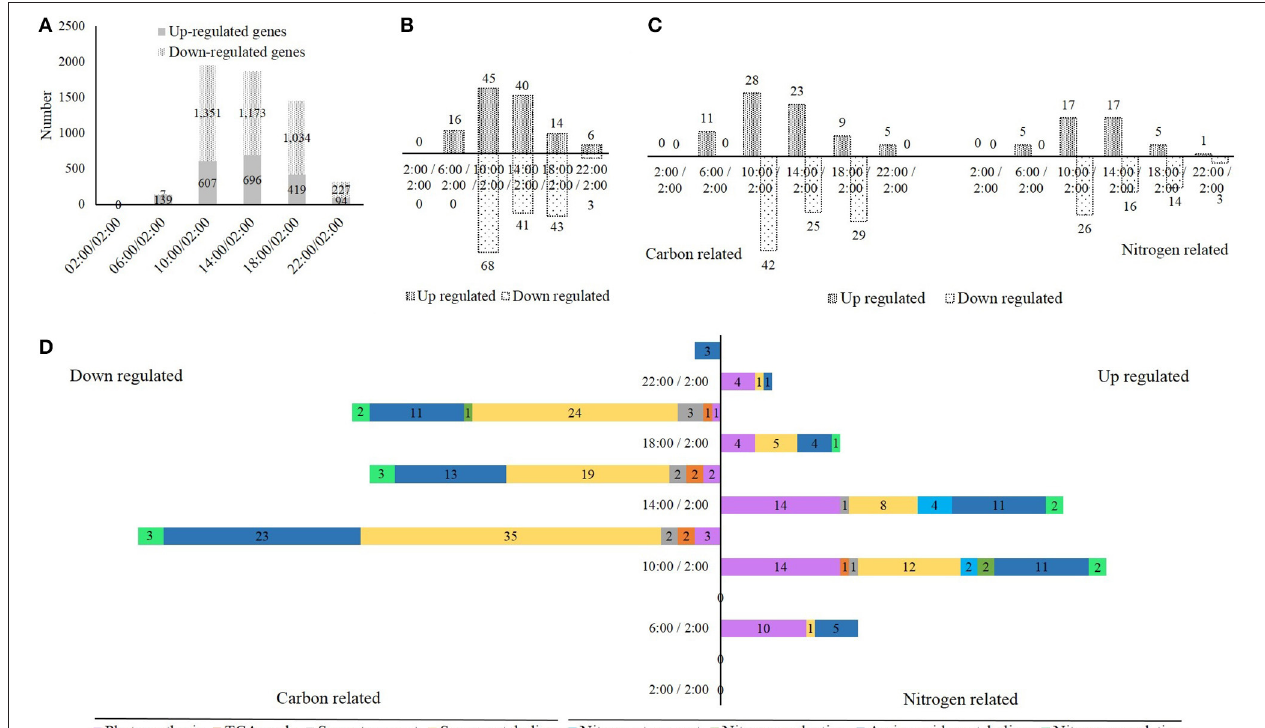
FIGURE 4 | (A) The number of up- and down-regulated genes in the rice shoots at the time of 2:00, 6:00, 10:00, 14:00, 18:00, and 22:00 when compared to the time of 2:00. (B,C) The number of up- and down-regulated carbon and nitrogen metabolism related genes at the time of 2:00, 6:00, 10:00, 14:00, 18:00, and 22:00 when compared to the time of 2:00. (D) The number of up- and down-regulated genes, which involved in photosynthesis, TCA cycle, sugar transport, sugar metabolism, nitrogen transport, nitrogen reduction, amino acids metabolism, and nitrogen regulation, at the time of 2:00, 6:00, 10:00, 14:00, 18:00, and 22:00 when compared to the time of